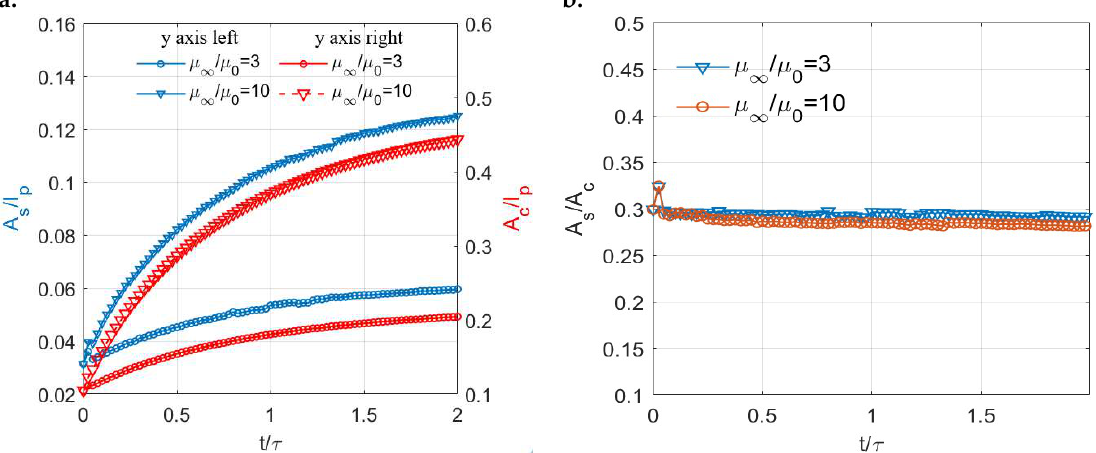
Figure 14. Separation of stick and slip regions with time for different viscoelastic materials: ( a ) µ ∞ 3 and ( b ) (cid:3091) (cid:3246) = 10 (the blue lines are the boundaries of the stick regions and the regions between the blue lines and red lines are the slip regions).